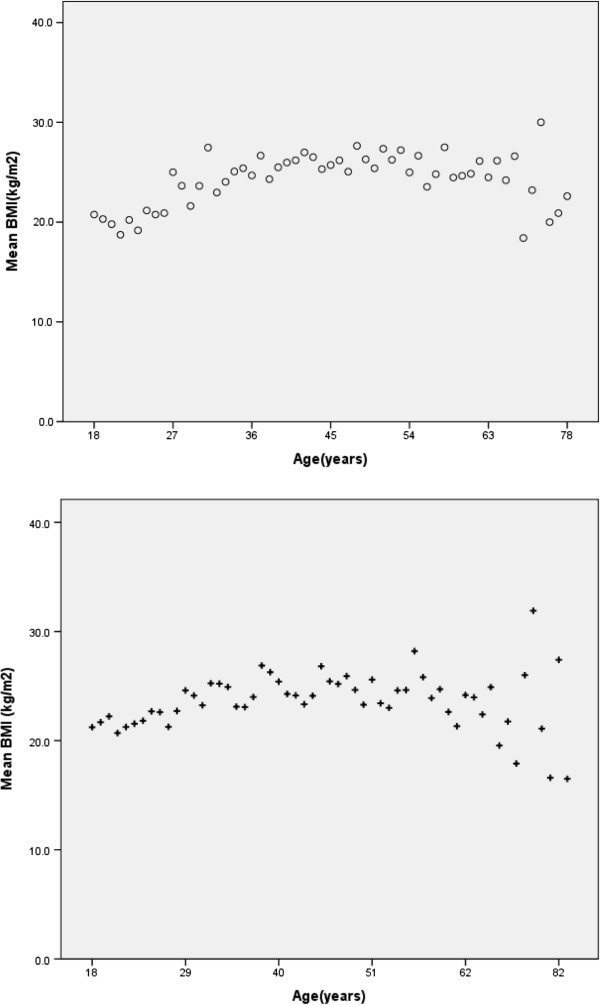
Relationship between BMI and age in (o) females (upper graph) and (+) males (lower graph).